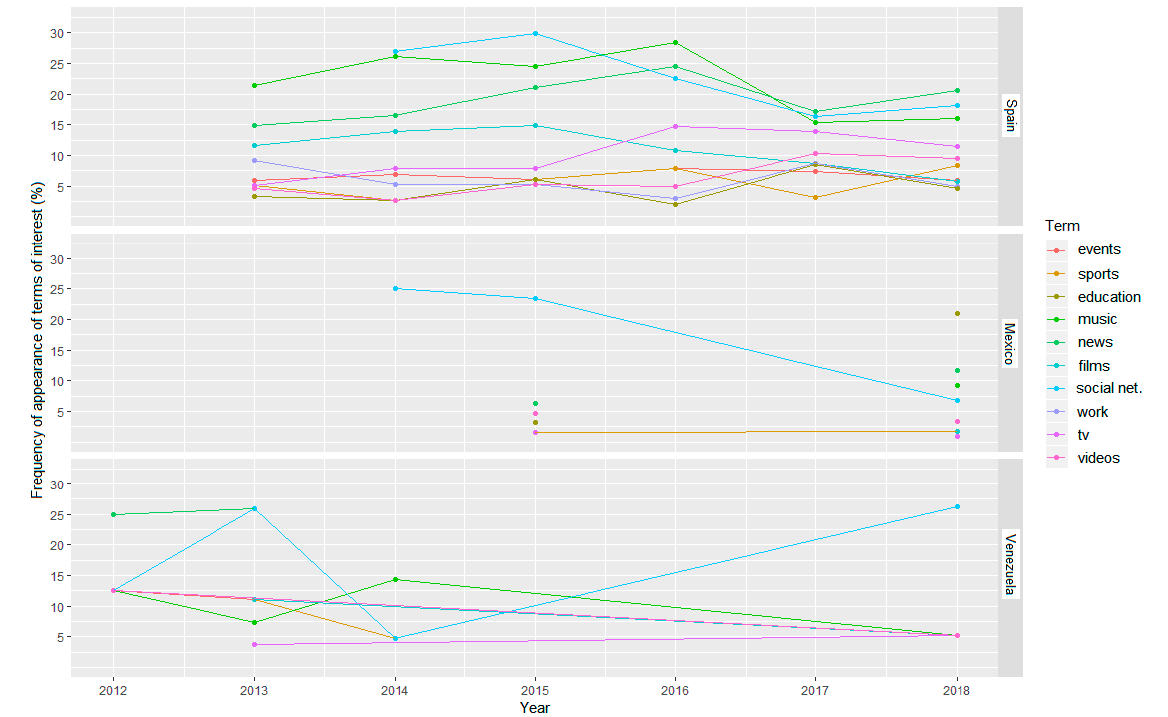
Figure 5. Temporal variation of the 10 most common terms named by respondents as topics of interest for web surfing (comparison of three selected countries).